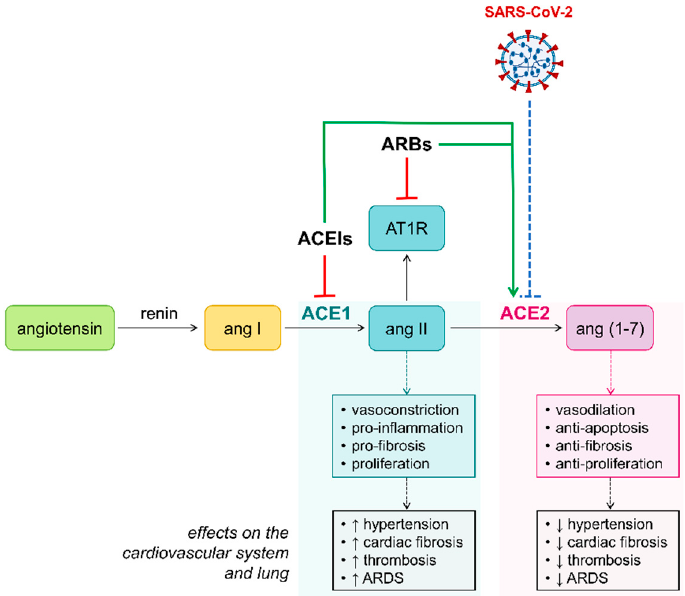
Figure 1. Schematic diagram showing the renin–angiotensin system (RAS) cascade and the effects on the cardiovascular system and lung. ACE1, angiotensin ‐ converting enzyme 1; ACE2, angiotensin ‐ converting enzyme 2; ang I, angiotensin I; ang II, angiotensin II; ang (1–7), angiotensin (1–7); AT1R, ang II type 1 receptor; ACEIs, angiotensin ‐ converting enzyme inhibitors; ARBs, angiotensin receptor blockers; ARDS, acute respiratory distress syndrome. Green arrows indicate that ACEIs / ARBs increase ACE2 levels in the heart, therefore increasing the susceptibility of cardiac cells to SARS ‐ CoV ‐ 2 infection [42,43]. Blue dotted hammerhead indicates the hypothetical effect of SARS ‐ CoV ‐ 2 on ACE2 expression in lung and heart, which is based on the reported effect of SARS ‐ CoV in the same body districts [45,46].